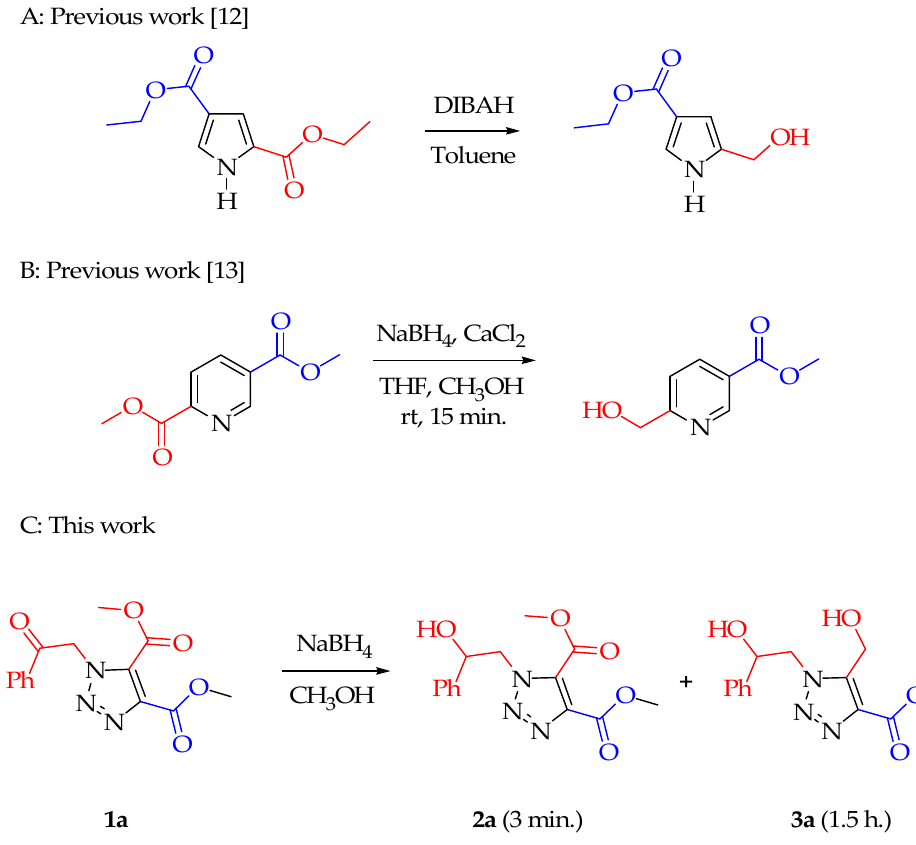
Scheme 1. Sodium borohydride (NaBH 4 ) and diisobutylaluminum hydride (DIBAH) reduction reactions of heteroaro- matic